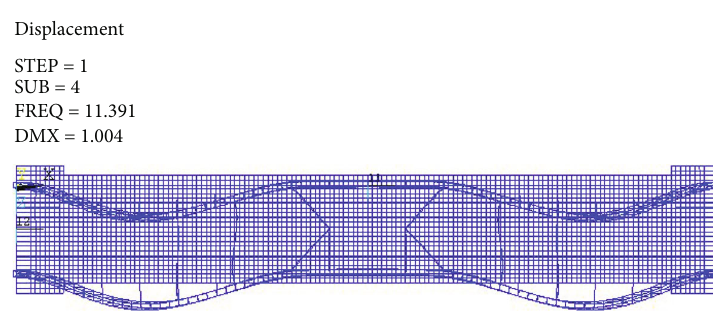
Figure 25: The fourth order buckling mode of arch bridge under case 7.